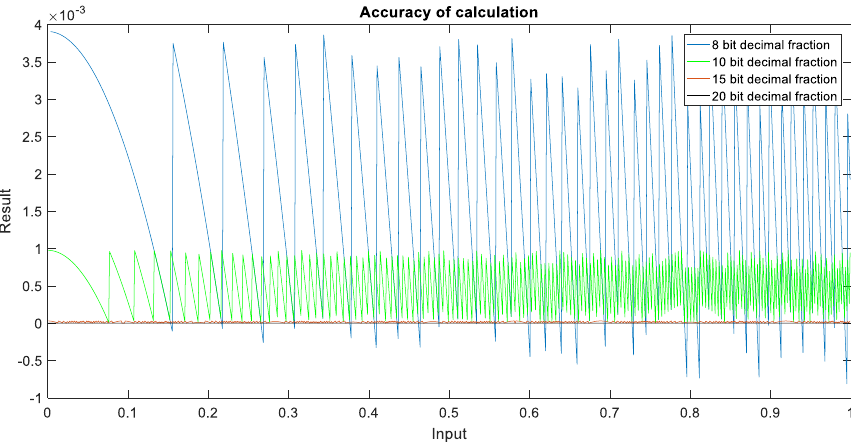
Figure 7. SINC interpolation kernel operation accuracy.